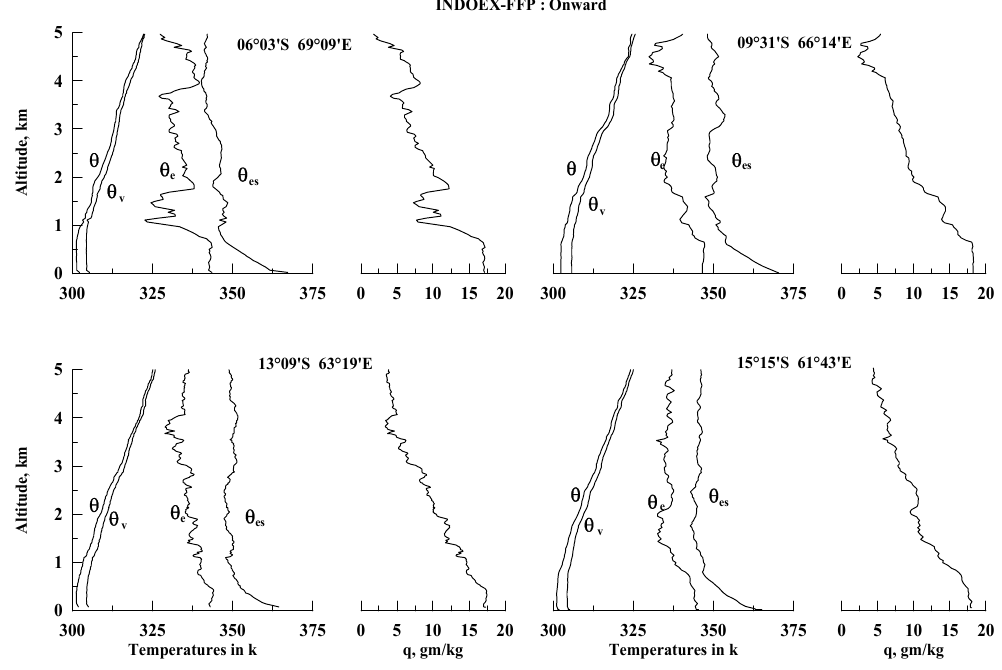
Fig. 6. Altitude profiles of potential temperature ( θ ), virtual potential temperature ( θ v ), equivalent potential temperature ( θ e ), saturated equivalent potential temperature ( θ es ) and mixing ratio ( q ) during the onward track of